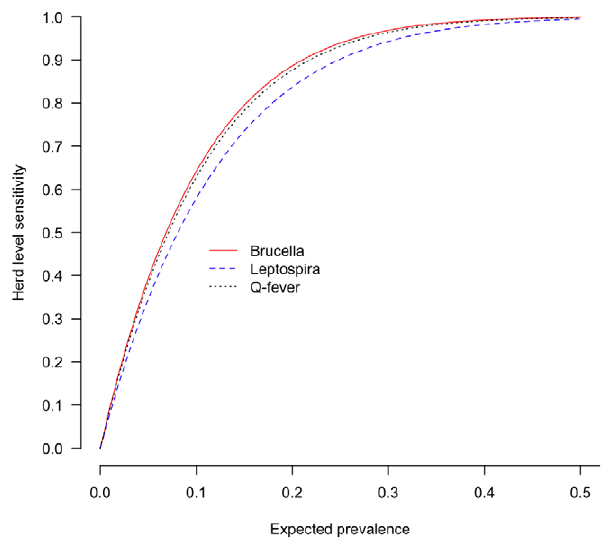
Figure 4. The herd-level sensitivities (HSe) for each of the three infections over a range of true seroprevalences assuming a perfect test specificity.